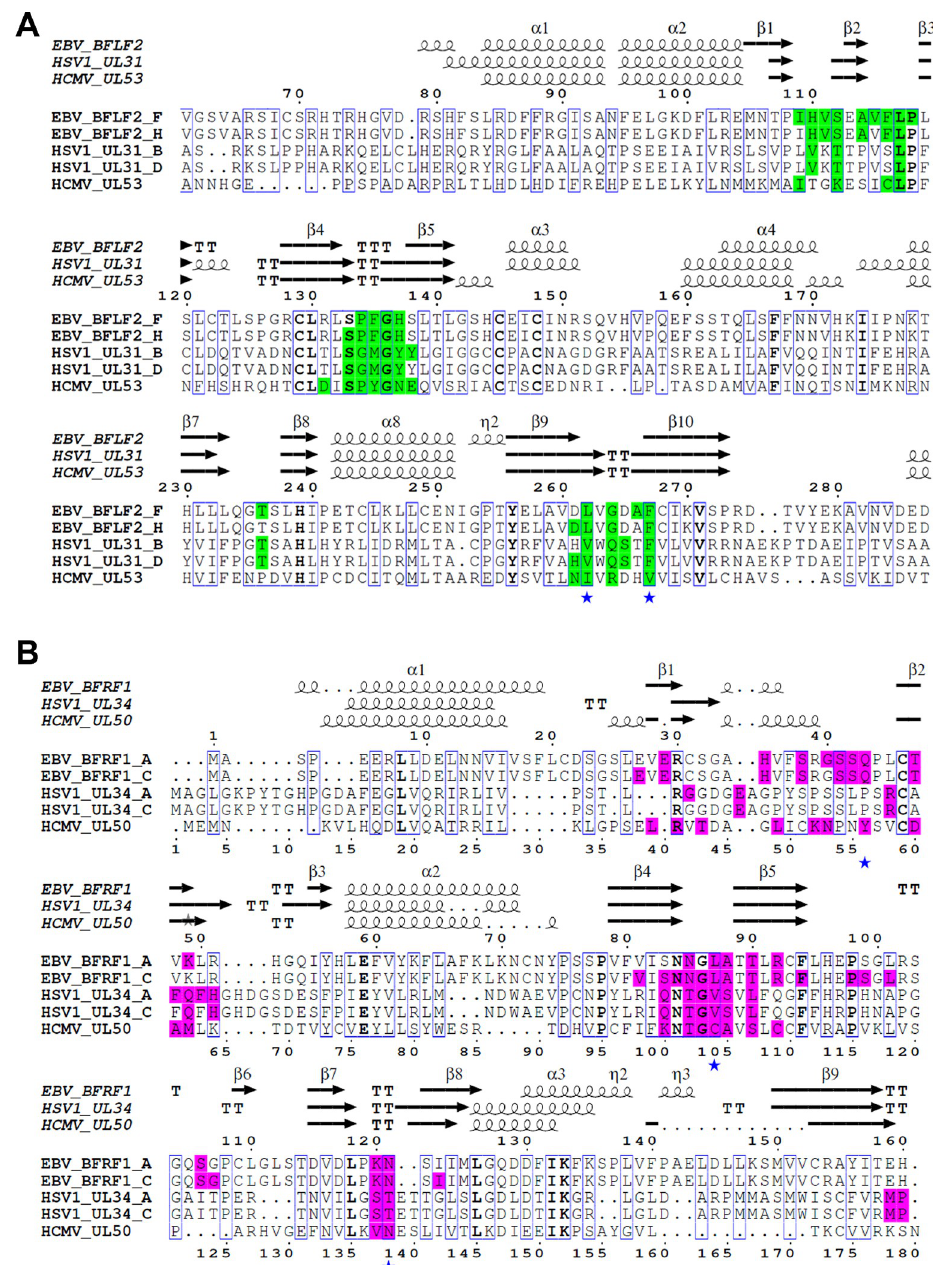
Fig 5. Sequence alignment of regions mediating NEC oligomerization. (A) Sequence alignment of UL31 homologs, EBV BFLF2, HSV-1 UL31, and HCMV UL53. (B) Sequence alignment of UL34 homologs, EBV BFRF1, HSV-1 UL34, and HCMV UL50. For HSV-1 and EBV NEC, two chains are shown for each NEC component because two distinct oligomeric interfaces were observed in crystals of both HSV-1 and EBV NEC. For simplicity, only regions containing the interface residues are shown. Alignment was made in Clustal Omega [47] and annotated using Espript [48]. Interface residues were assigned by PDBePISA [46]. Residues with 30% or more of their surface area buried at the oligomeric interface are highlighted in green and mauve in UL31 and UL34 homologs, respectively. Interface residues mutated in this study are marked with a blue star below the sequence.